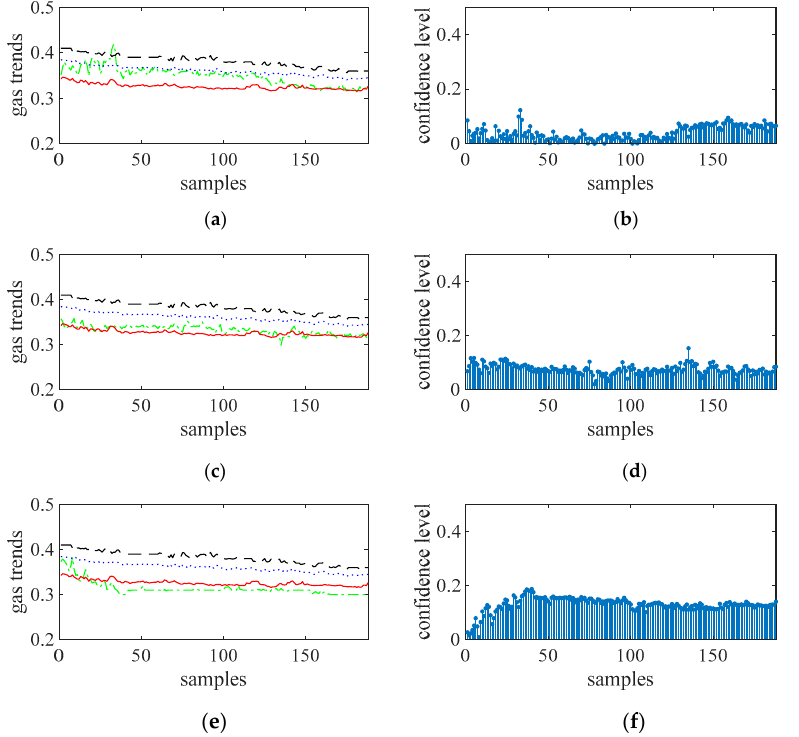
Figure 10. The measured values of sensors 7 to 9 and their confidence level. ( a ) gas sensor 7, ( b ) confidence level of gas sensor 7, ( c ) gas sensor 8, ( d ) confidence level of gas sensor 8, ( e ) gas sensor 9, ( f ) confidence level of gas sensor 9.